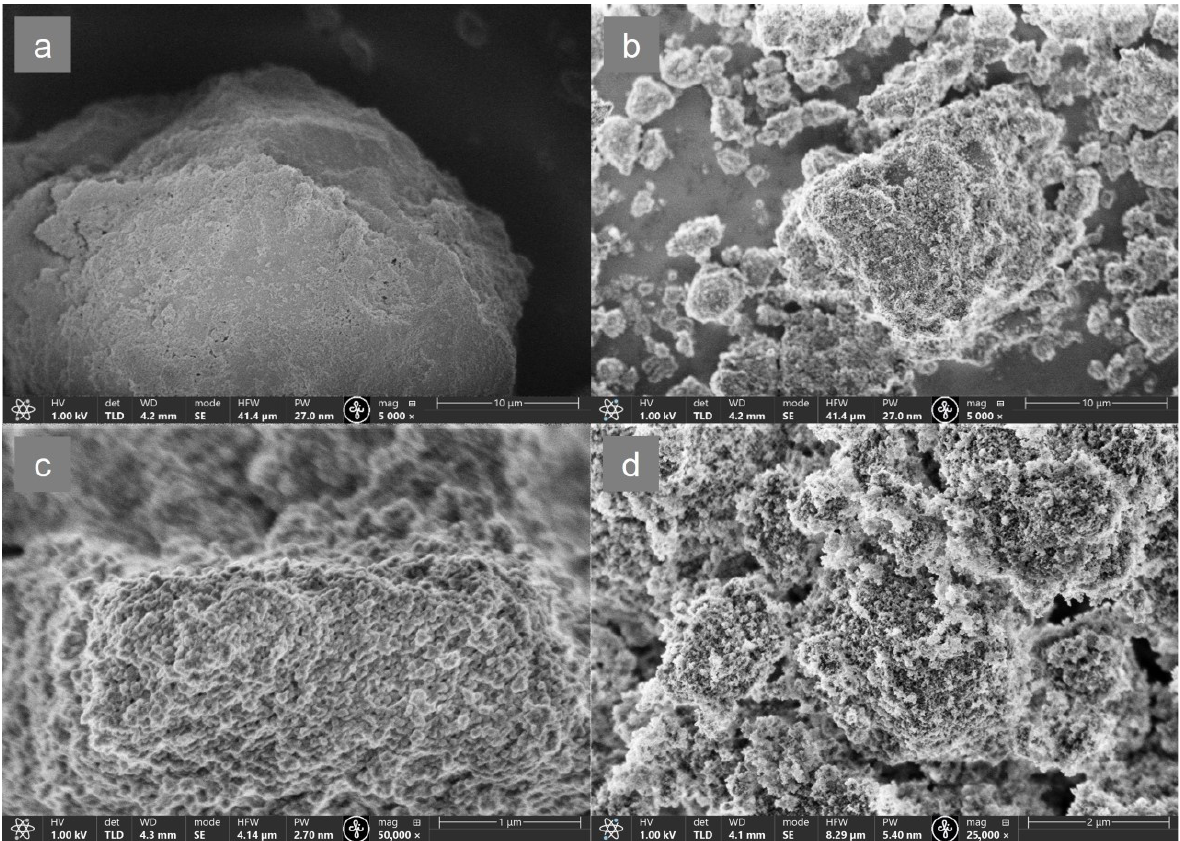
Figure 8. SEM image of ( a , c ) UiO-66-BTEC, ( b , d ) UiO-66-BTEC-A-15 at different magnifications. Energy-dispersive X-ray spectroscopy (EDX or EDS) analysis was used to character- ize the element distribution in the MOF-composite. Elemental mapping analysis of